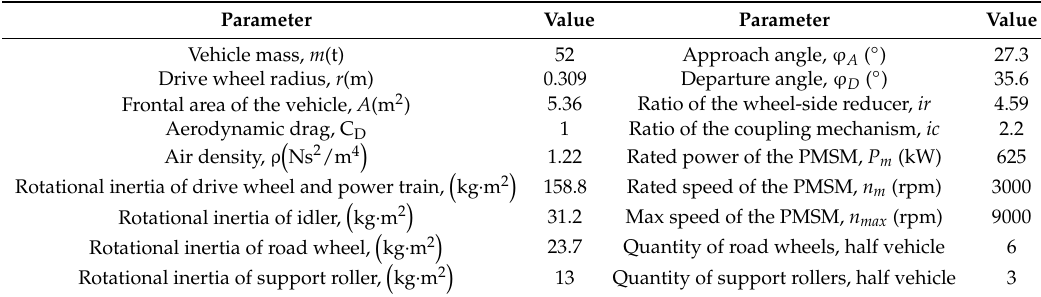
Table 1. Main parameters of the DDTV for